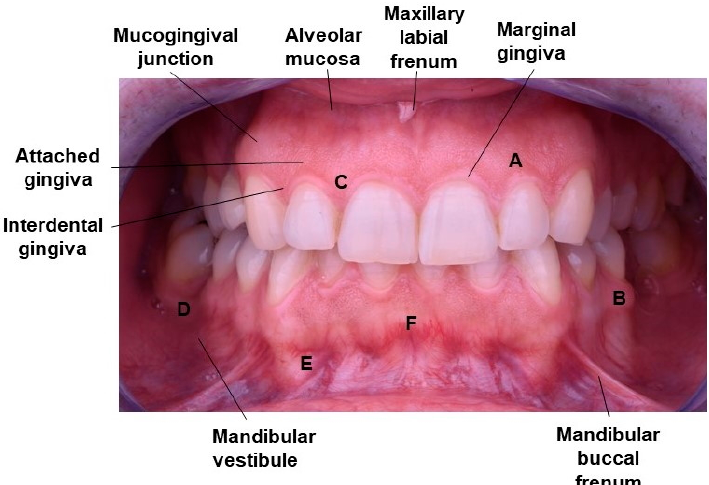
Figure 1. Clinical appearance of gingiva: ( A ) Attached gingiva above and interdental papilla below; ( B ) mucogingival line separating attached gingival from mucosa; ( C ) free gingival margin; ( D ) posterior vestibular fornix; ( E ) anterior vestibular fornix or mucobuccal fold; ( F ) frenum area.